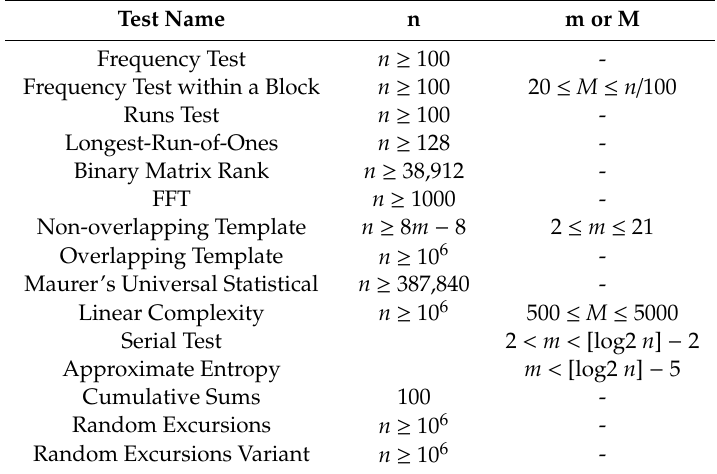
Table 3. Statistical Tests Within National Institute of Standard and Technologies (NIST) SP 800-22. Test Name n m or M Frequency Test n ≥ 100 - Frequency Test within a Block n ≥ 100 20 ≤ M ≤ n / 100 Runs Test n ≥ 100 - Longest-Run-of-Ones n ≥ 128 - Binary Matrix Rank n ≥ 38,912 - FFT n ≥ 1000 - Non-overlapping Template n ≥ 8 m − 8 2 ≤ m ≤ 21 Overlapping Template n ≥ 10 6 - Maurer’s Universal Statistical n ≥ 387,840 - Linear Complexity n ≥ 10 6 500 ≤ M ≤ 5000 Serial Test 2 < m < [log2 n ] − 2 Approximate Entropy m < [log2 n ] − 5 Cumulative Sums 100 - Random Excursions n ≥ 10 6 - Random Excursions Variant n ≥ 10 6